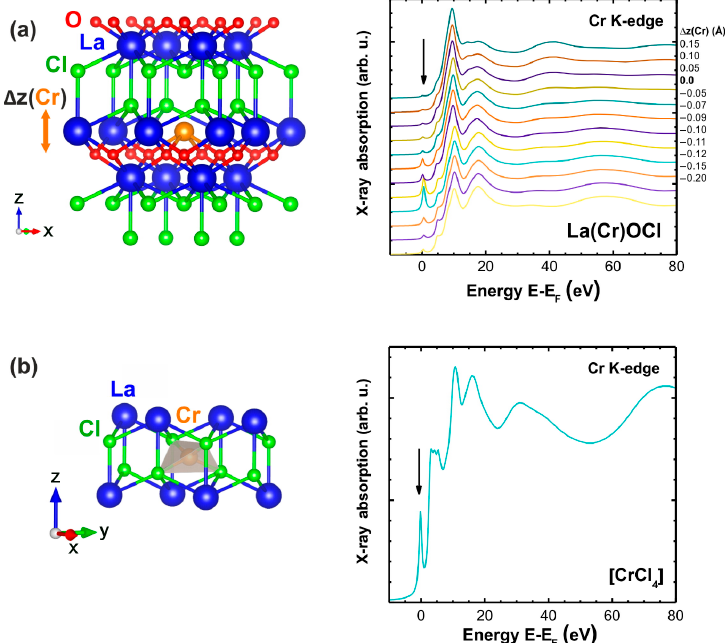
Figure 8. ( a ) A structural model of the lanthanum ion substitution by chromium (left). Calculated Cr K ‐ edge XANES spectra for different positions of chromium atoms displaced along the c ‐ axis by Δ z relative to the lanthanum position (right). ( b ) A fragment of the structural model of the chromium environment with the tetrahedral coordination by chlorine atoms (left). The calculated Cr K ‐ edge XANES spectrum (right). The pre ‐ edge peak is indicated by arrows.